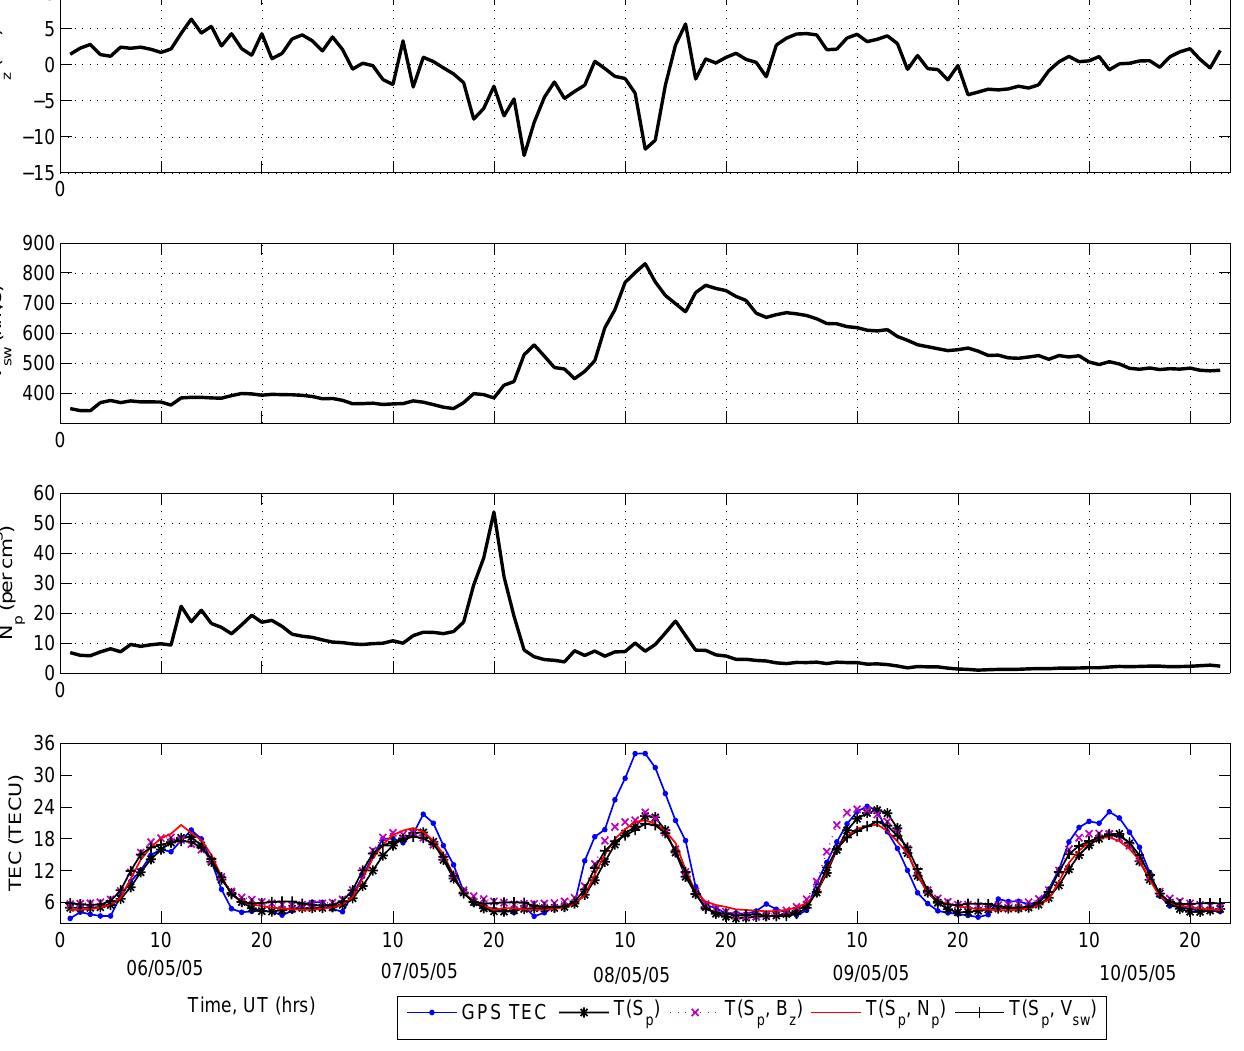
magnetic storms. Jakowski et al. (1999) studied the relation- ship between the solar wind and TEC before and around solar minimum at different European latitudes using V sw as one of the parameters and found that there exists an